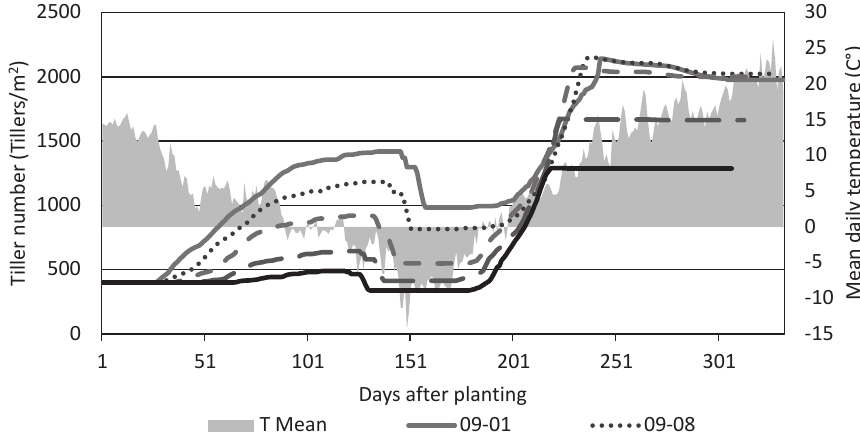
Fig. 3. Simulated tiller number (tillers m -2 ) at different sowing time, plotted with observed mean 3-year daily temperature during growth period